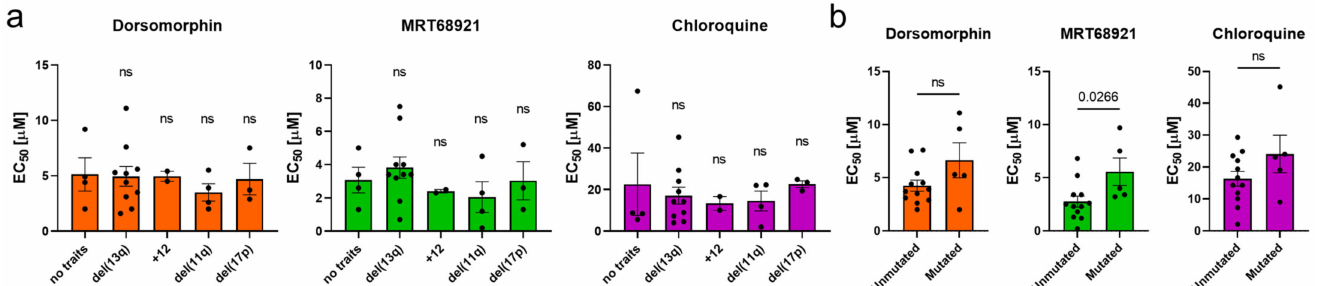
Figure 2. The potency of autophagy inhibitors in cells of CLL patients with different genetic characteristics. The EC 50 values of autophagy inhibitors after 48 h with respect to ( a ) del(13q), trisomy 12 (+12), del(11q), del(17p), and ( b ) mutational status of IGHV. Data are means ± SEM. Each dot corresponds to the cells derived from a specific patient with CLL. One-way ANOVA with Dunnett’s multiple comparisons test and unpaired Student’s t -test were used, respectively. Not significant (ns) denotes p >